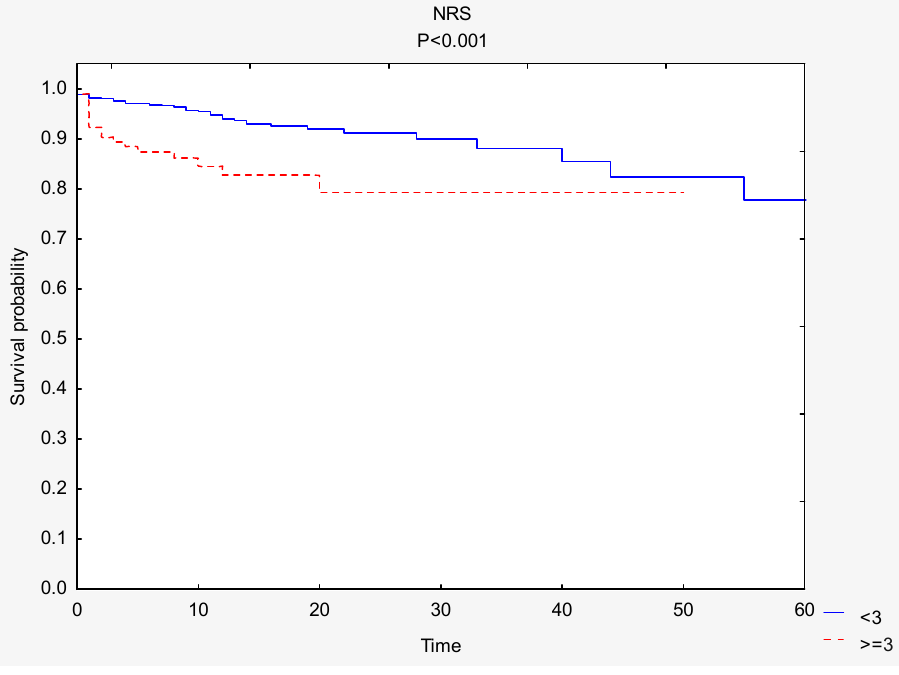
Figure 4. Comparison of survival curves depending on LDL result. Abbreviations: LDL, low-density lipoprotein.